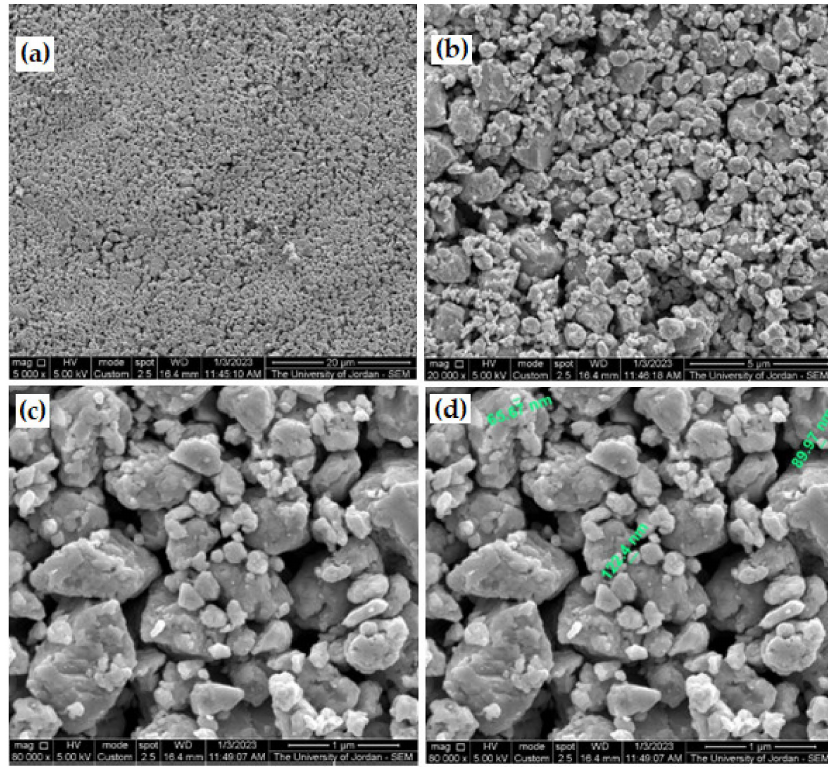
Figure 7. SEM micrographs (SEI) of water-separated galena powder for 5 min using different magni- fications. ( a ) 5000 × , ( b ) 20,000 × , ( c ) 80,000 × , and ( d ) same micrograph of ( c ) with nanoscale